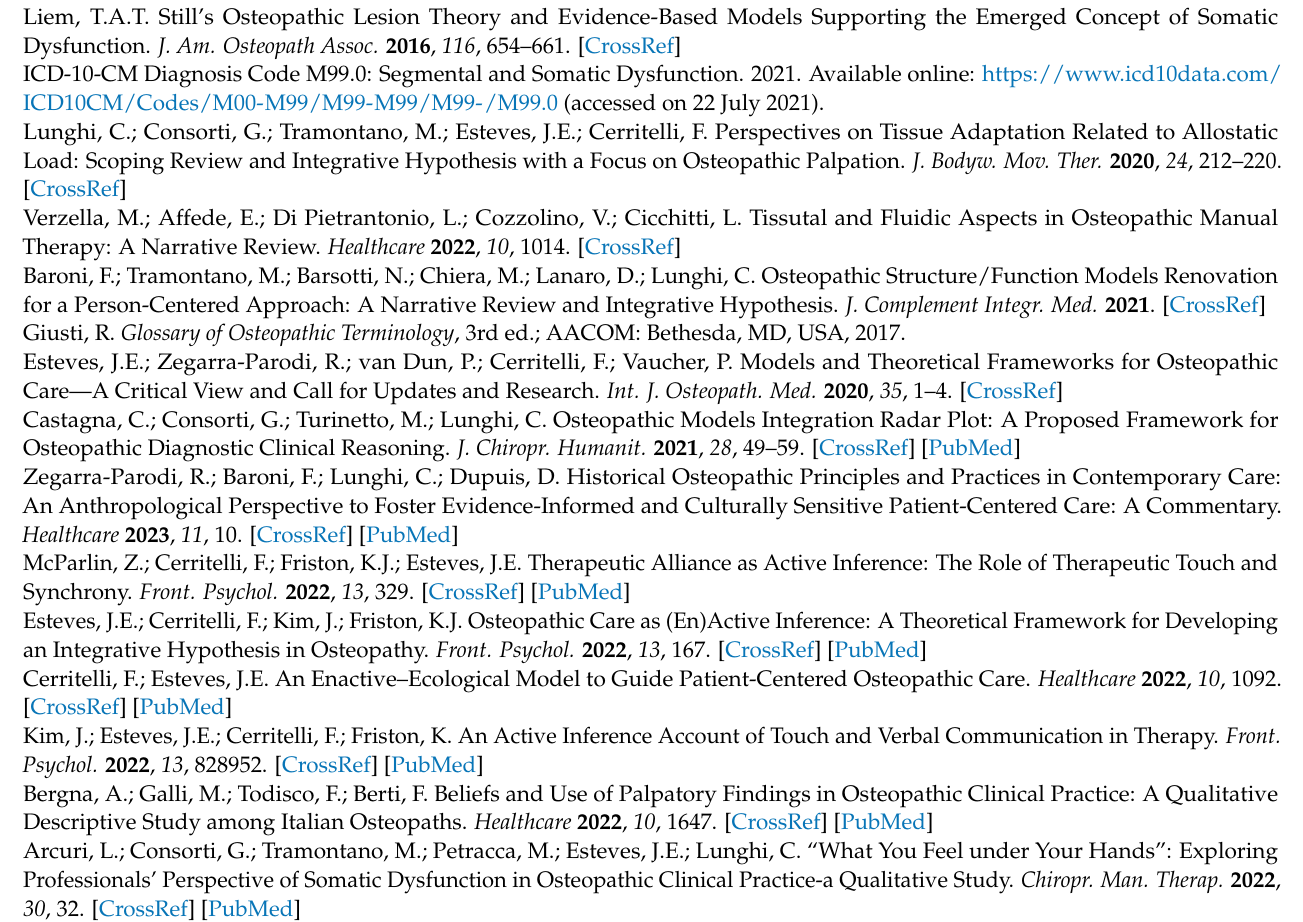
Figure A5. Clinical scenario 5.